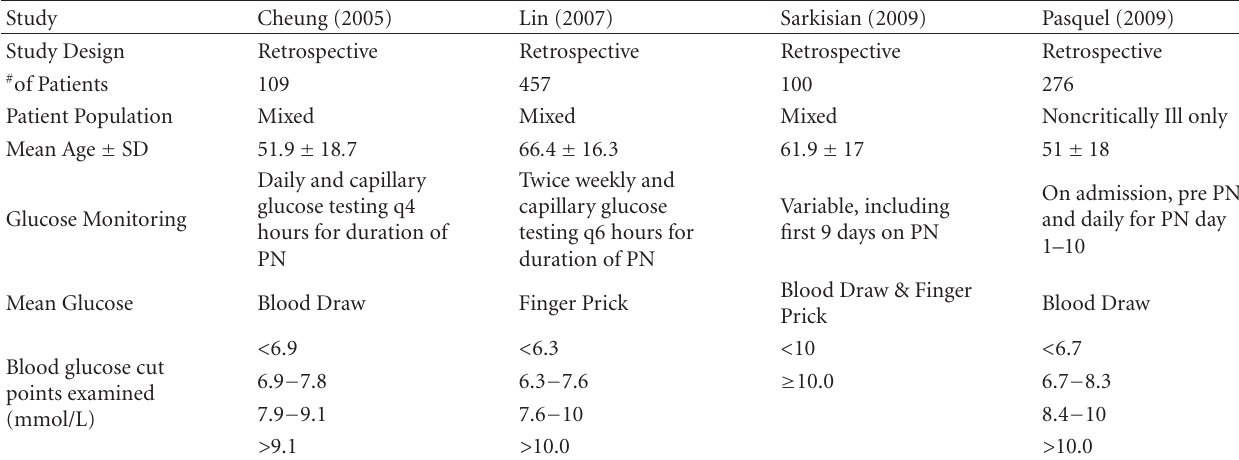
Table 1: Characteristics of the studies examining hyperglycemia in patients receiving